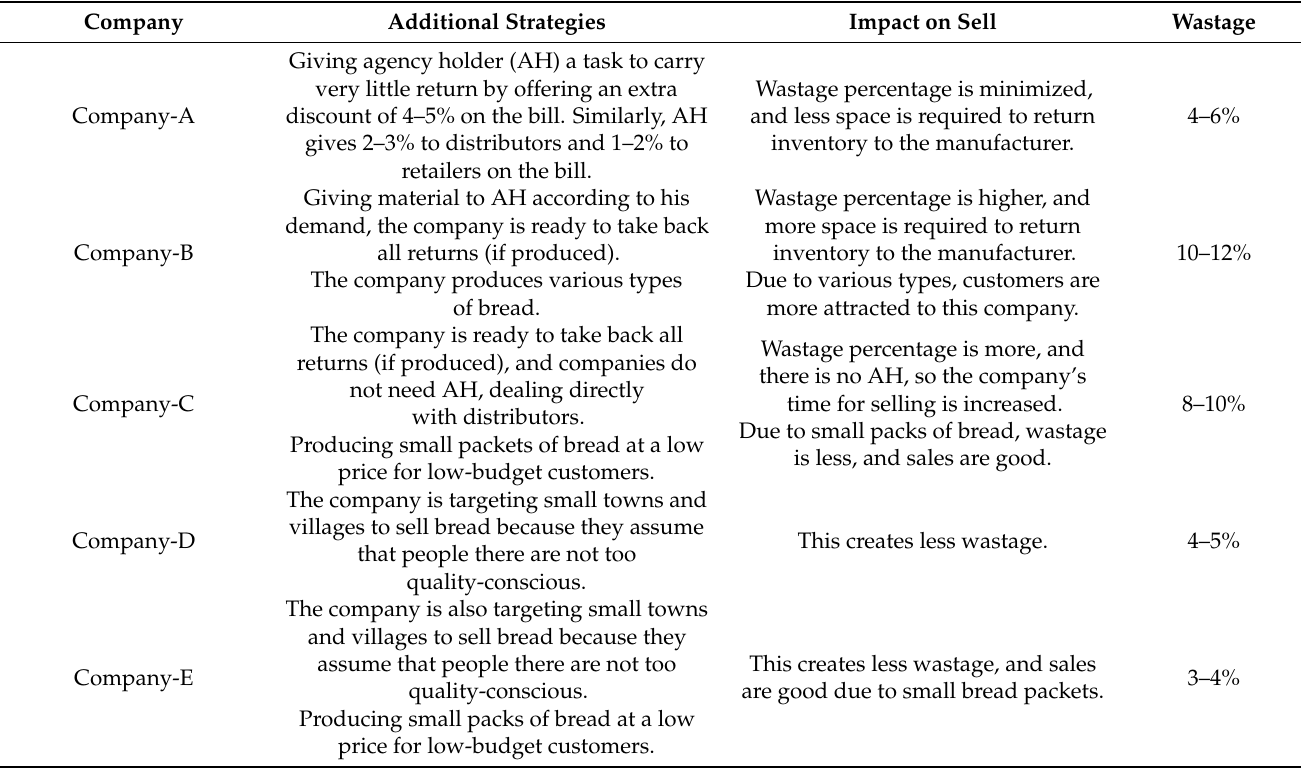
Table 3. Waste concerning the additional